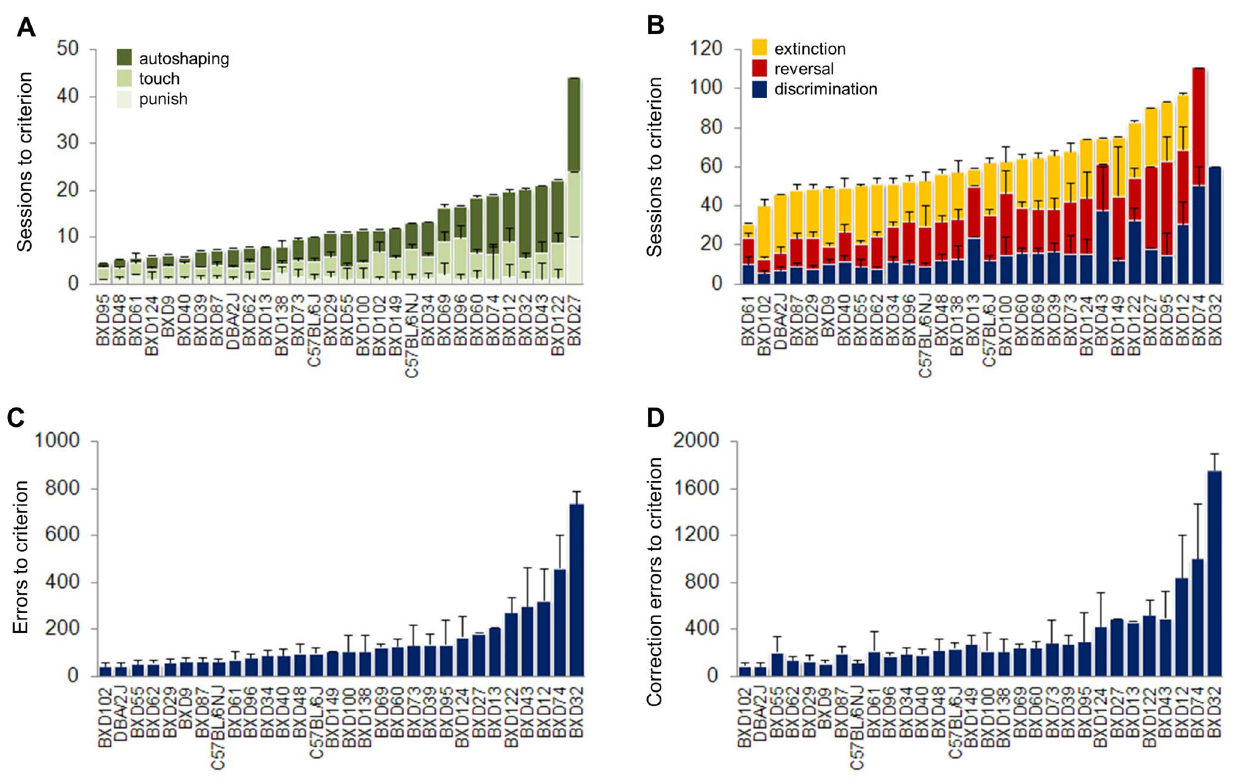
Figure 4. BXD-RI strain differences in training performance, and in discrimination and reversal learning. ( A ) Sessions to autoshaping, touch and punish criterion. ( B ) Sessions to discrimination, reversal and extinction criterion. Errors ( C ) and correction errors ( D ) to discrimination criterion. n=1–16 per strain. Data are Means 6 SEM.